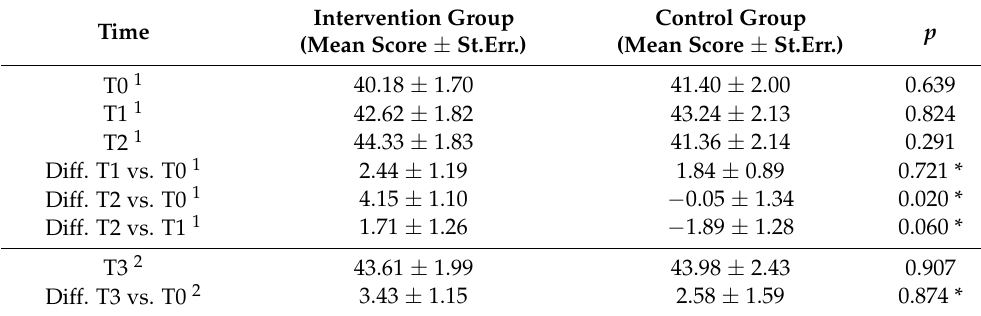
Table 3. Questionnaire B. Effect of nutrition education on food preferences by participants. Intervention Group Time (Mean Score ± St.Err.)